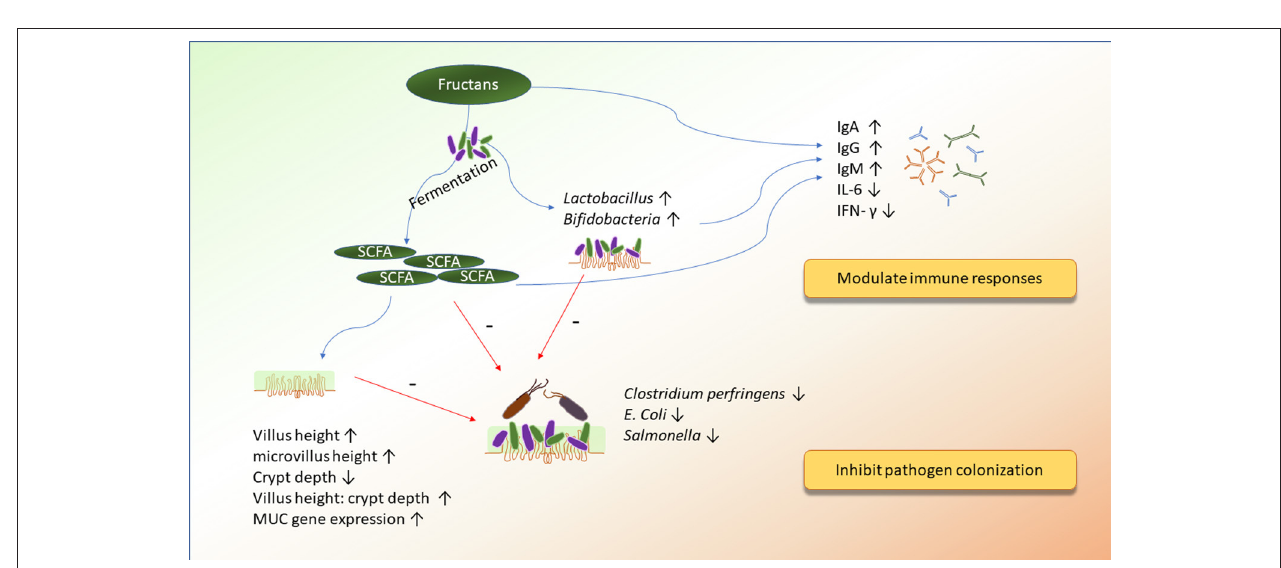
FIGURE 1 | The potential mechanisms of action of MOS on improving immunity and inhibiting pathogen colonization.